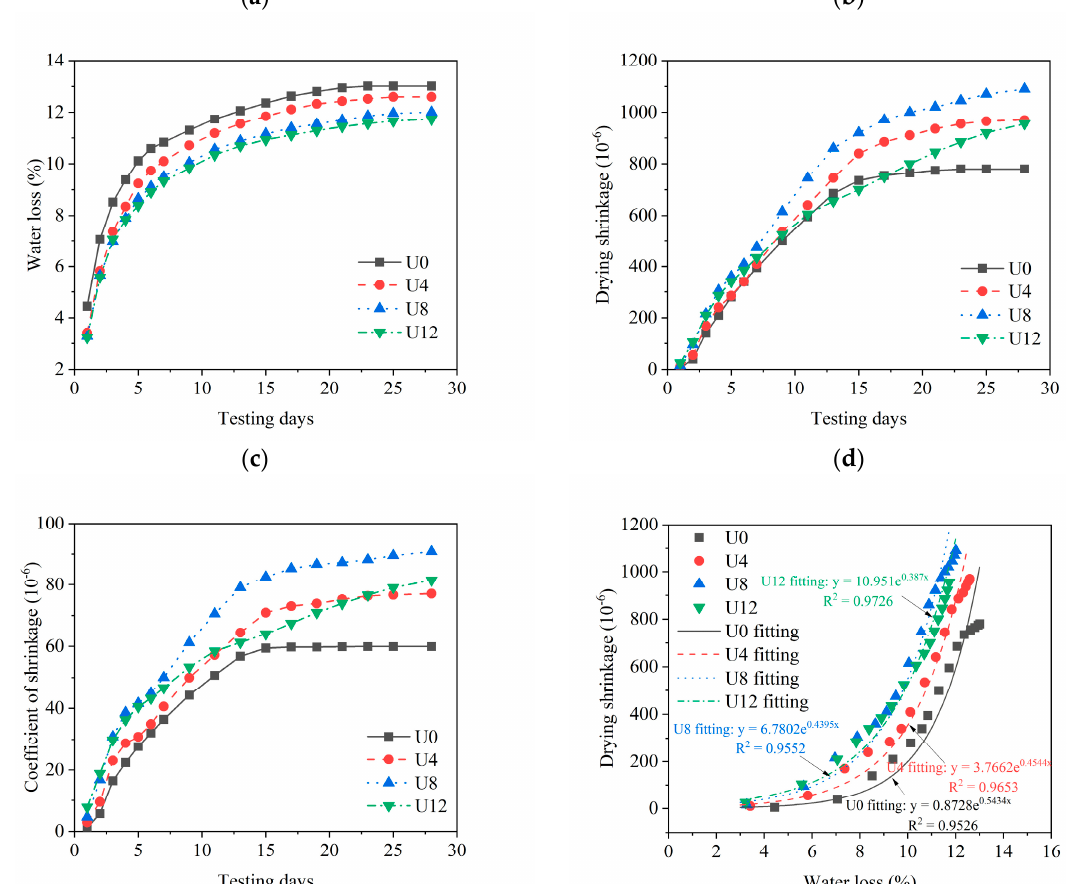
Figure 5. ( a ) Water loss; ( b ) Drying shrinkage; ( c ) Coefficient of shrinkage; ( d ) Relationship between water loss and drying shrinkage. U0 fitting: y = 0.8728e 0.5434x , R 2 = 0.9526; U4 fitting: y = 3.7662e 0.4544x , R 2 = 0.9653; U8 fitting: y = 6.7802e 0.4395x , R 2 = 0.9552; U12 fitting: y = 10.951e 0.387x , R 2 = 0.9726.